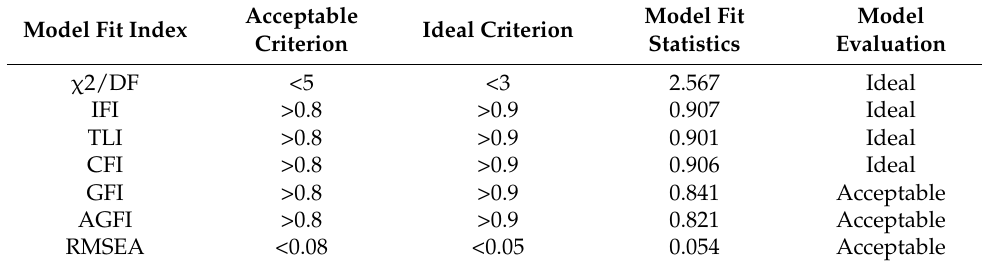
Table 2. Model fit